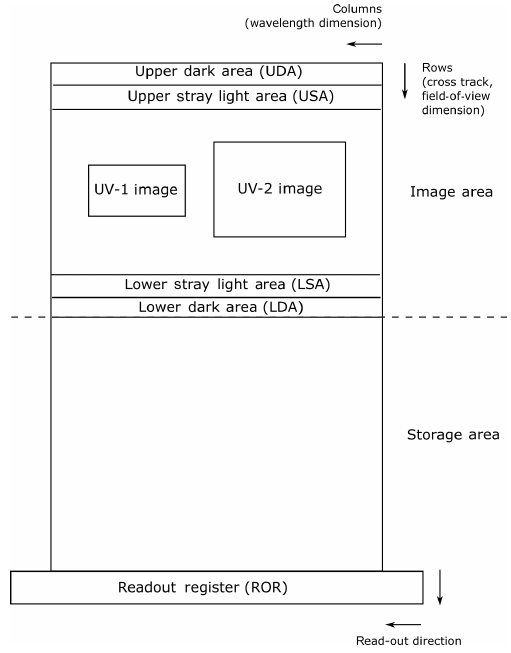
Figure 4. UV CCD detector layout with two wavelength channels, UV1 and UV2. The VIS CCD detector has a similar layout, how- ever, with only one wavelength channel.